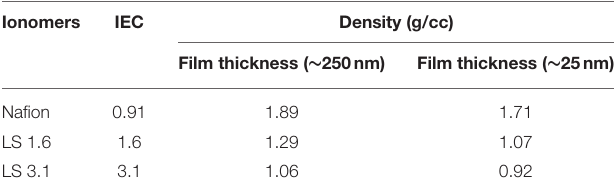
TABLE 2 | Density of Nafion and LS x ionomers in thin